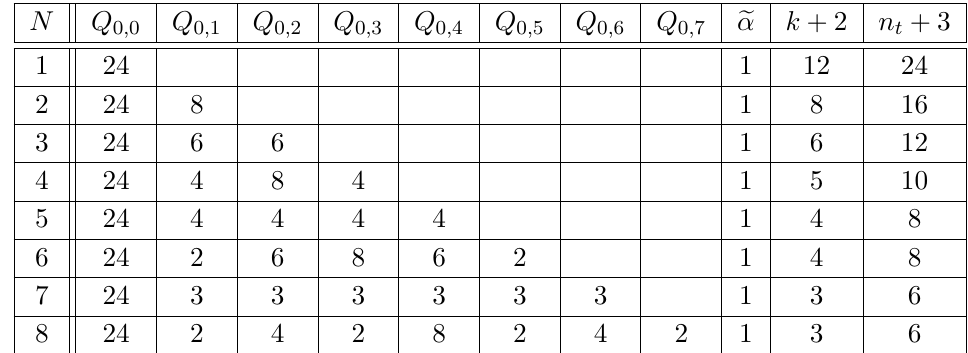
Table 1 . Useful data on Z N orbifolds of K3 (cid:2) S 1 (cid:2) e S 1 for calculating 5d partition function from 4d partition function. Note from the last two columns that 2( k + 2) = n t + 3. and n given l